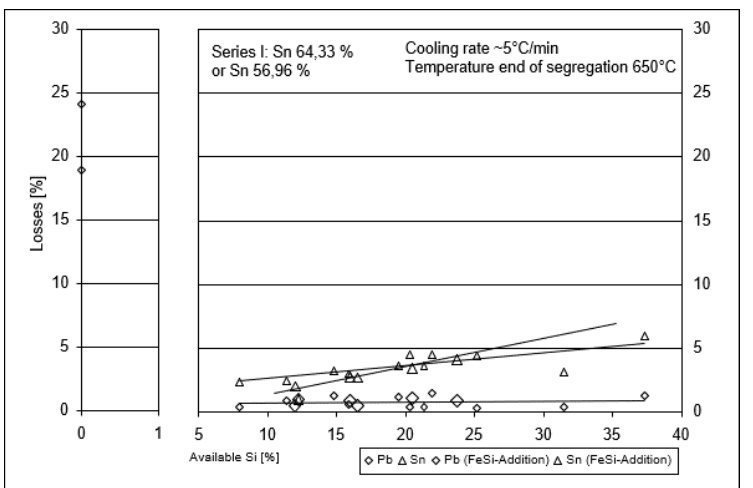
Figure 11. Lead and tin losses in the silicide product depending on the “available” silicon (cooling rate 5 ◦ C/min, temperature segregation 650 ◦